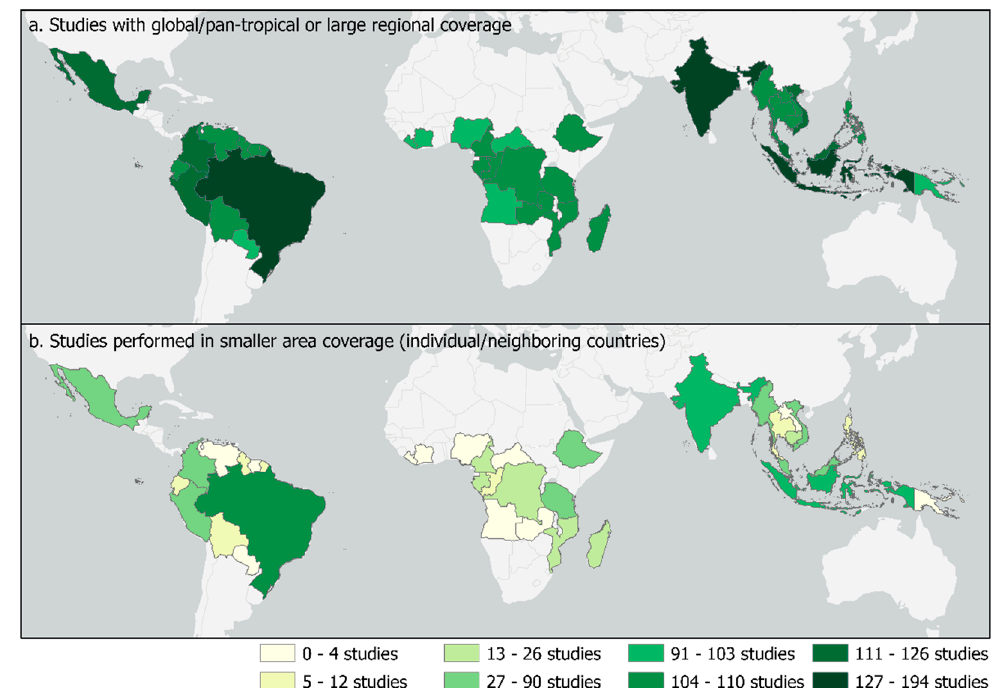
Figure 2. Number of studies performed in each of the selected countries considering ( a ) global/pan- tropical and large regional studies, and ( b ) studies performed in small areas (individual /neighbor- ing countries).